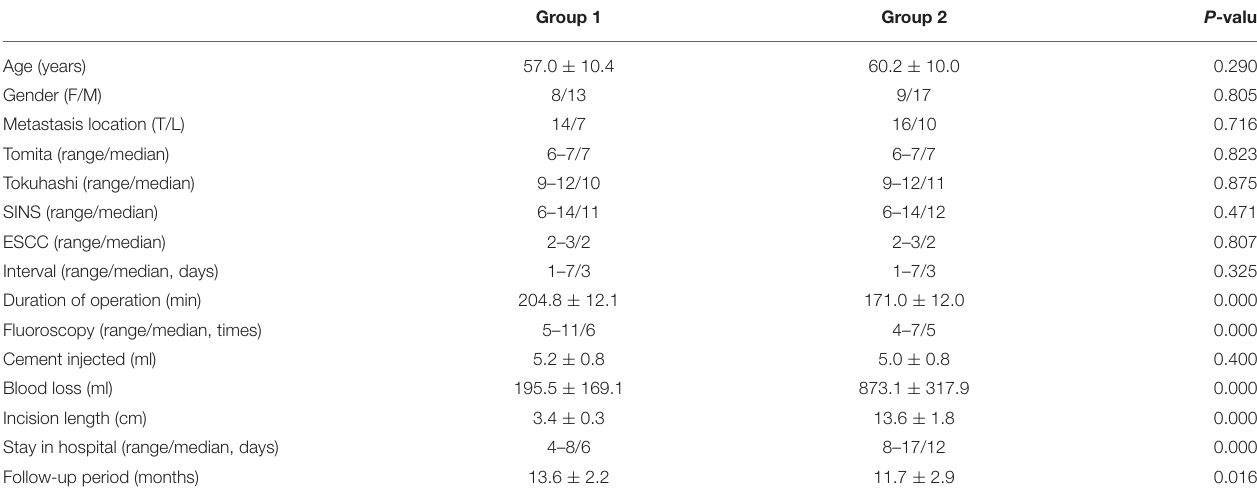
TABLE 1 | Comparison of clinical data between groups 1 and 2.